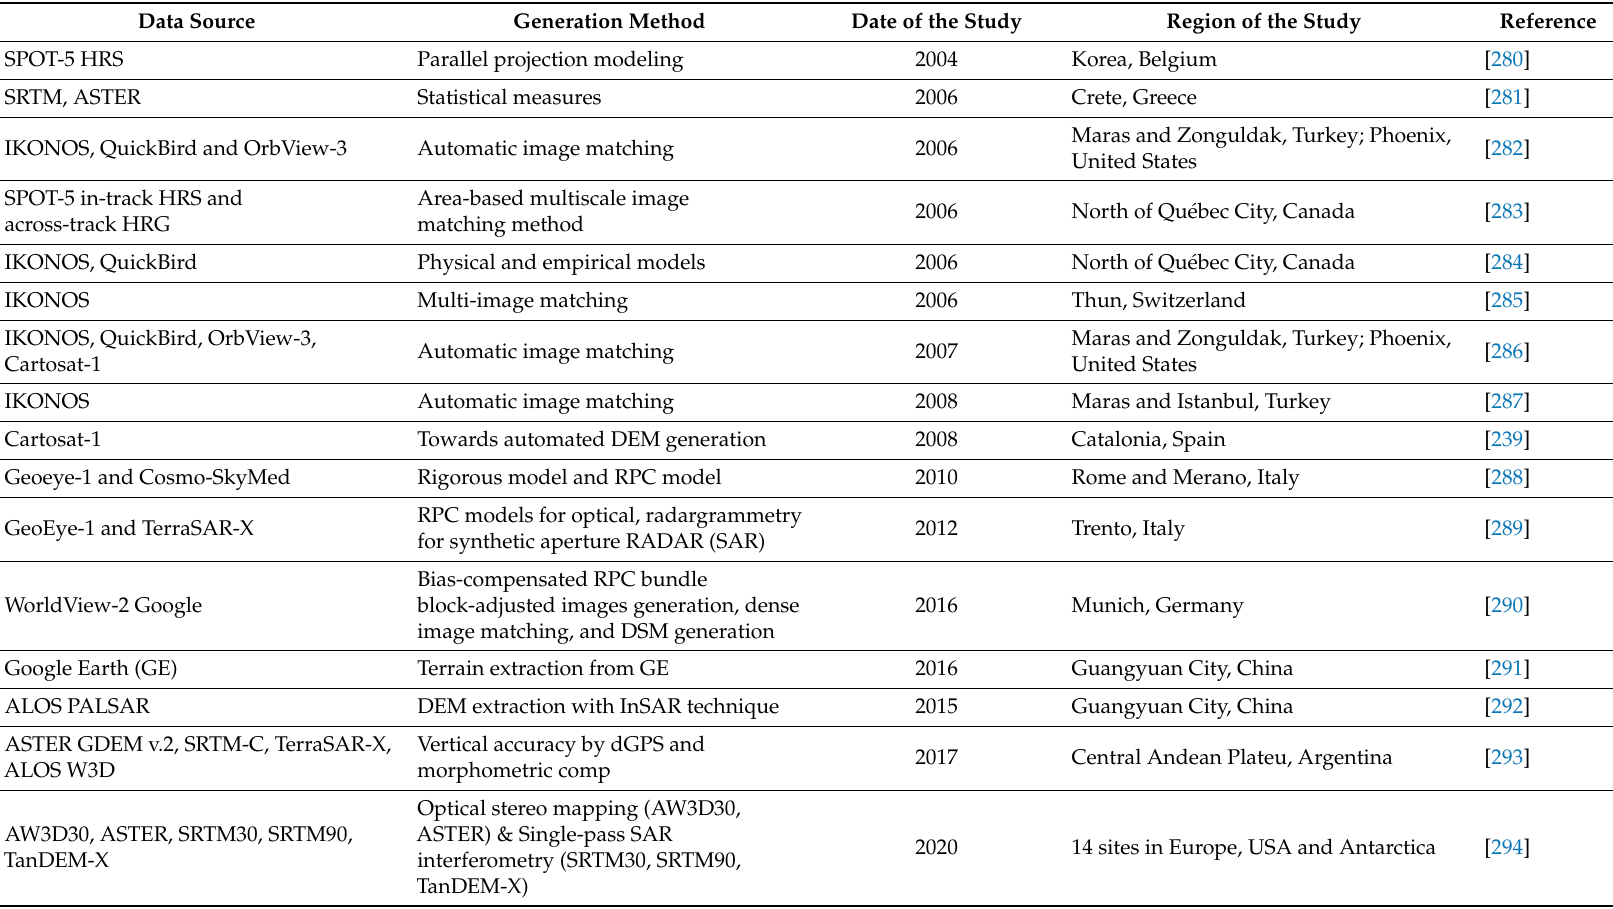
Table 3. Specification of output Digital Elevation Models (DEMs, modified after Hawker